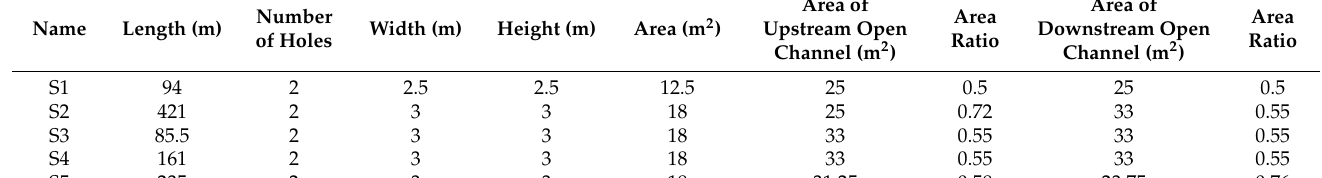
Table 1. The parameters of inverted siphons.